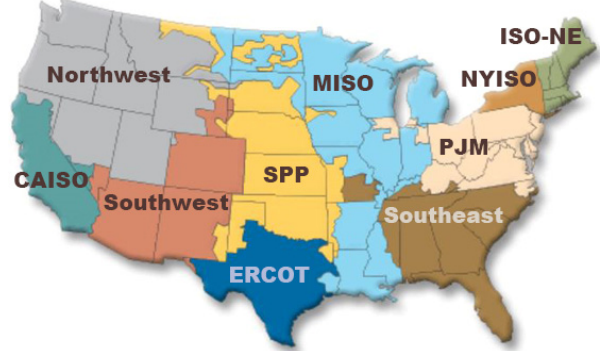
Figure 2. Electric Power Markets in the USA [1].